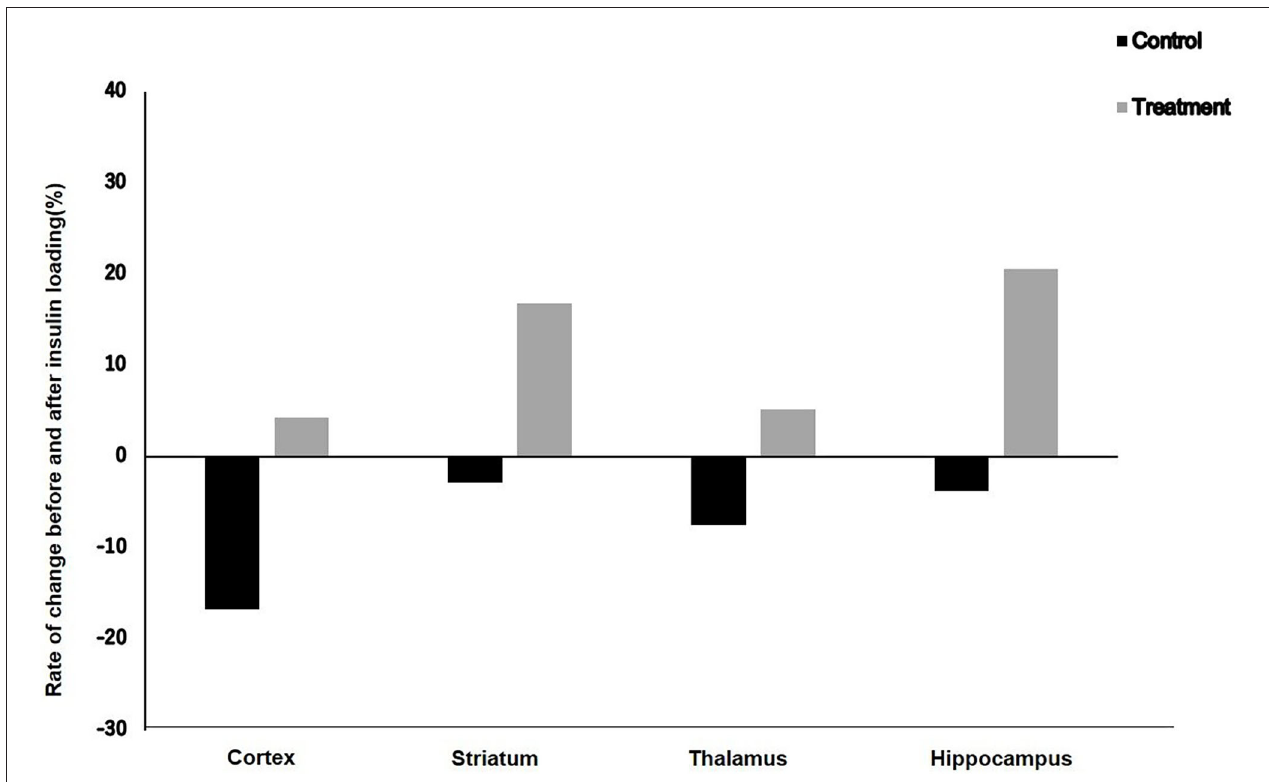
FIGURE 3 | Rate of change in 18 F-FDG uptake level before and after insulin loading in control and treatment